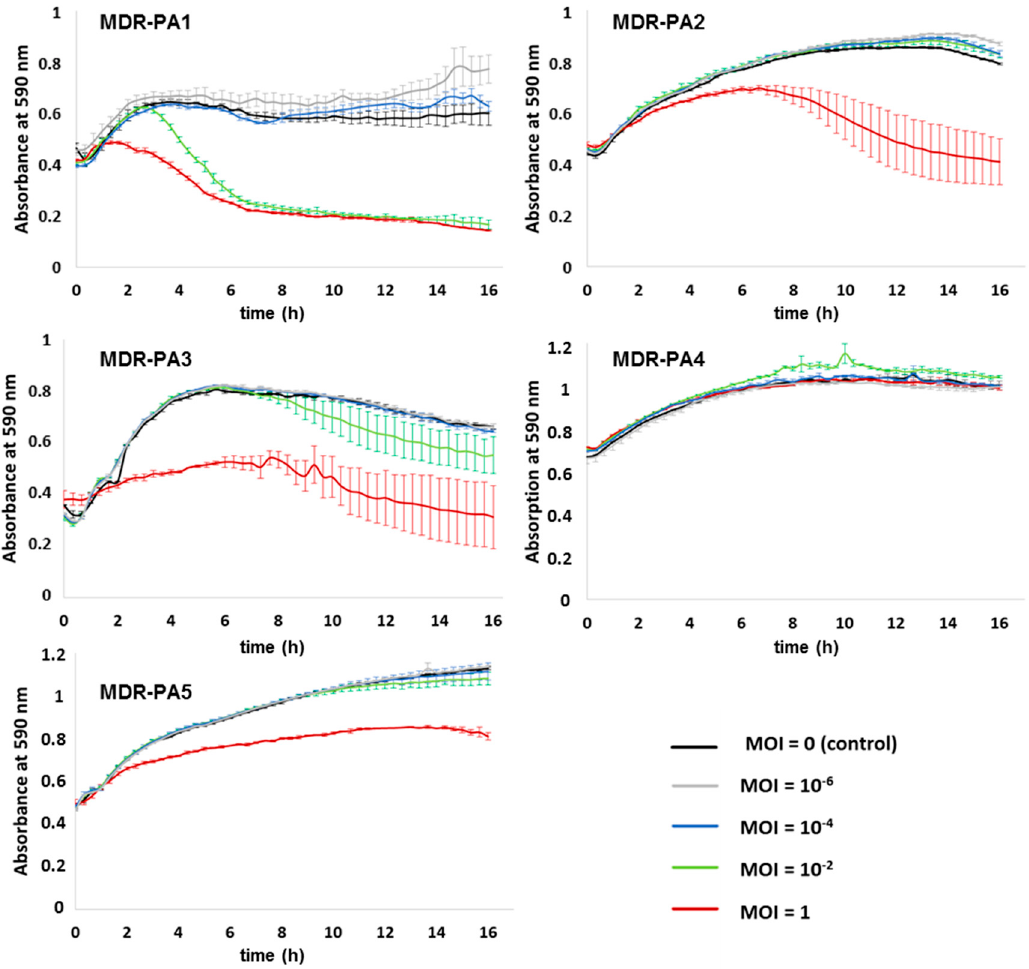
Figure 7. Activity of phage SL4 against planktonic cells of five different multi-drug resistant P. aeruginosa strains (MDR-PA1-5). Each experiment was performed in triplicate, and bars indicate standard deviation.